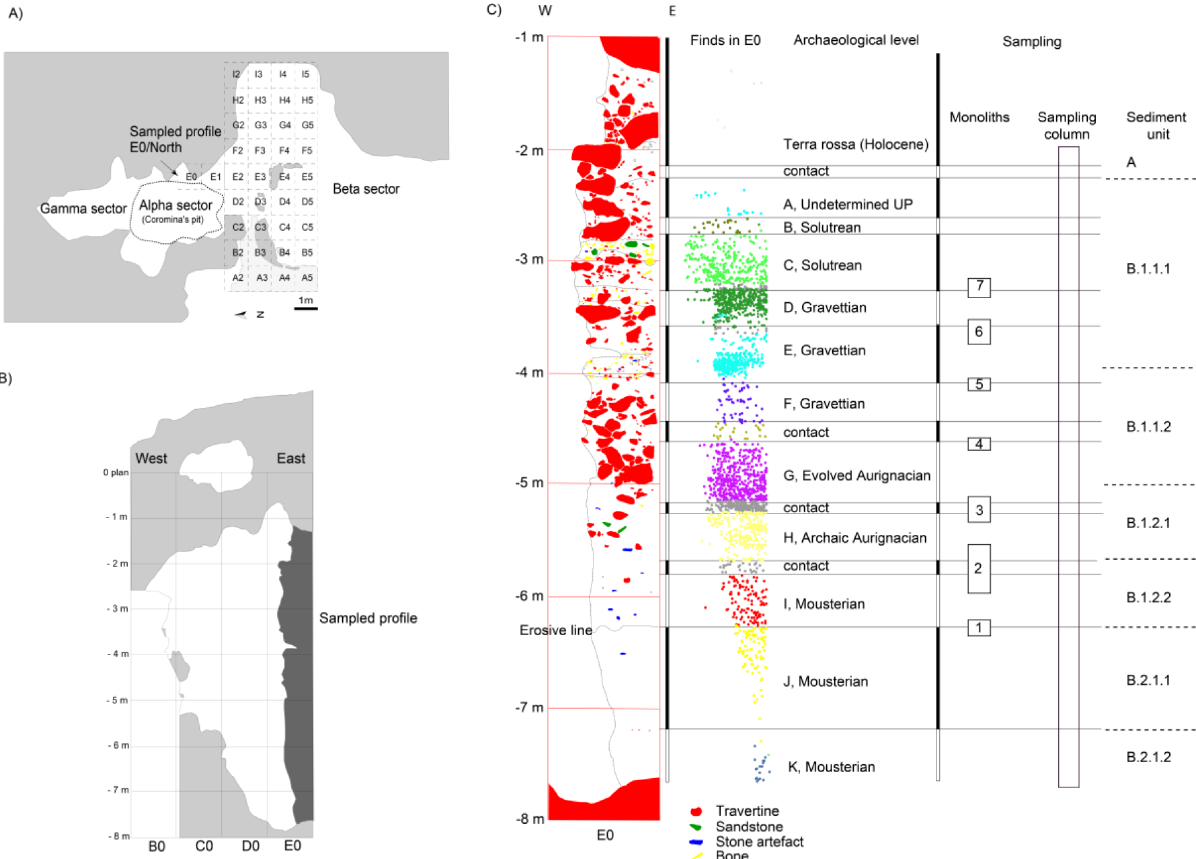
Figure 2. Excavation plan (A) and the north profile at square E 0 (B) with projected locations of archaeological finds from square E 0 , and cultural attribution of these finds (C) . Profile sampling was conducted along a c. 20cm wide column in the north profile, except of archaeological levels E and D, which were sampled at the east profile of square E 0 . Monoliths for preparation of thin sections were taken from suspected or obvious transitions between selected archaeological levels. Boundaries between sediment units were delineated by field evidence, except for the lower boundary of unit B.1.1.1 which was geochemically defined by a sudden rise in phosphorus, copper and